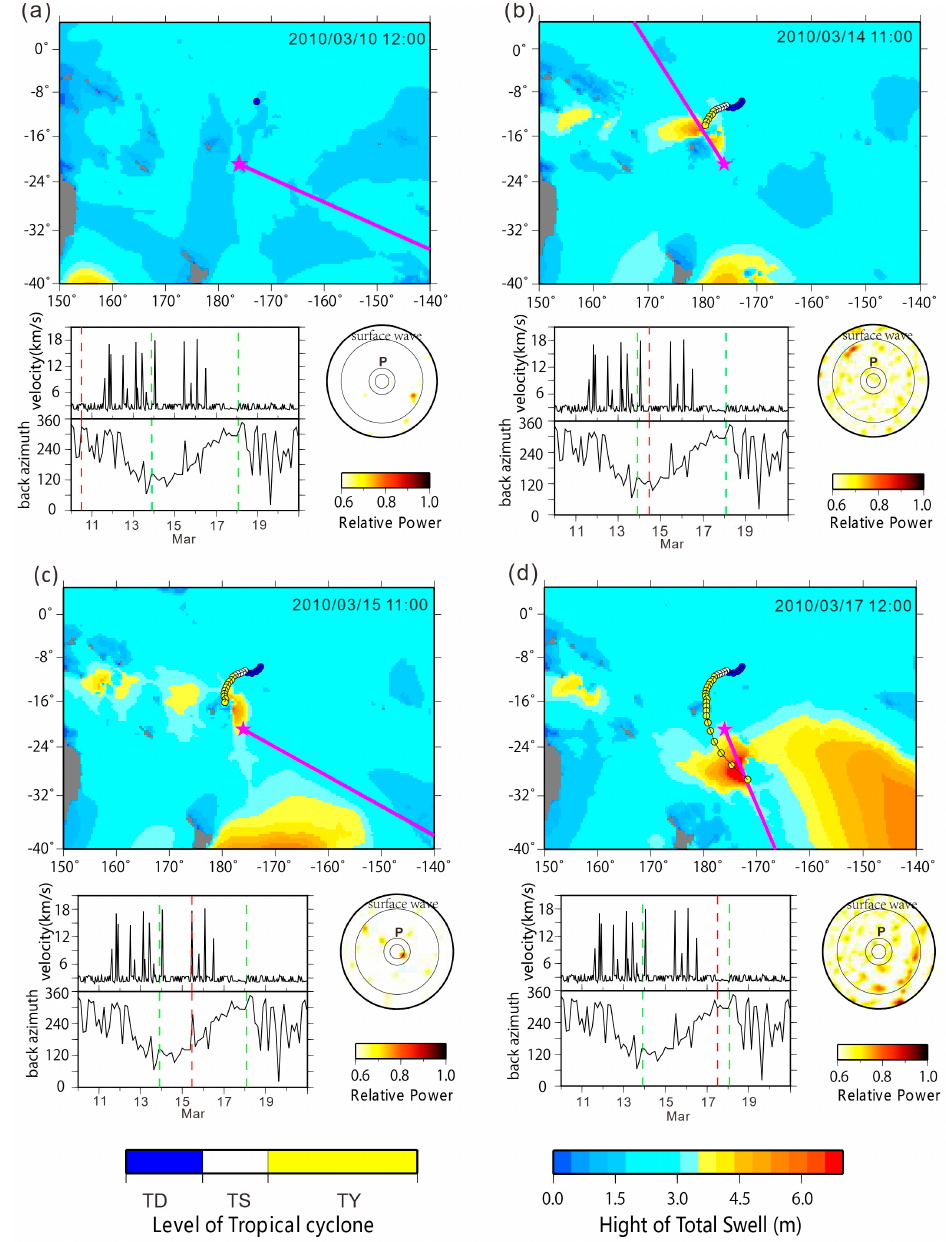
Figure 3. Results of F-K analysis in the range of 0.1 to 0.5 Hz at four different times during the TOMAS cyclone’s lifetime period ( a − d ). The comparison between the F-K result, the location of the cyclone center, and the swell is shown in the upper portion of 3 ( a − d ). The purple star is the location of the YL array, and the purple ray is the back azimuth from F-K. The circles are the locations of the centers of TOMAS. The back azimuth and velocity of the peak energy from F-K as a function of time are shown in the lower left part. The beginning and ending times when the F-K results have a good correlation with the cyclone are marked by the green dashed lines at 21:00 on 13 March and 03:00 on 18 March. The red dashed line marks the corresponding time of the upper portion. The lower right portion is the slowness measurement at the corresponding time of the upper portion from F-K. The P wave slowness and surface wave slowness are marked as concentric circles.